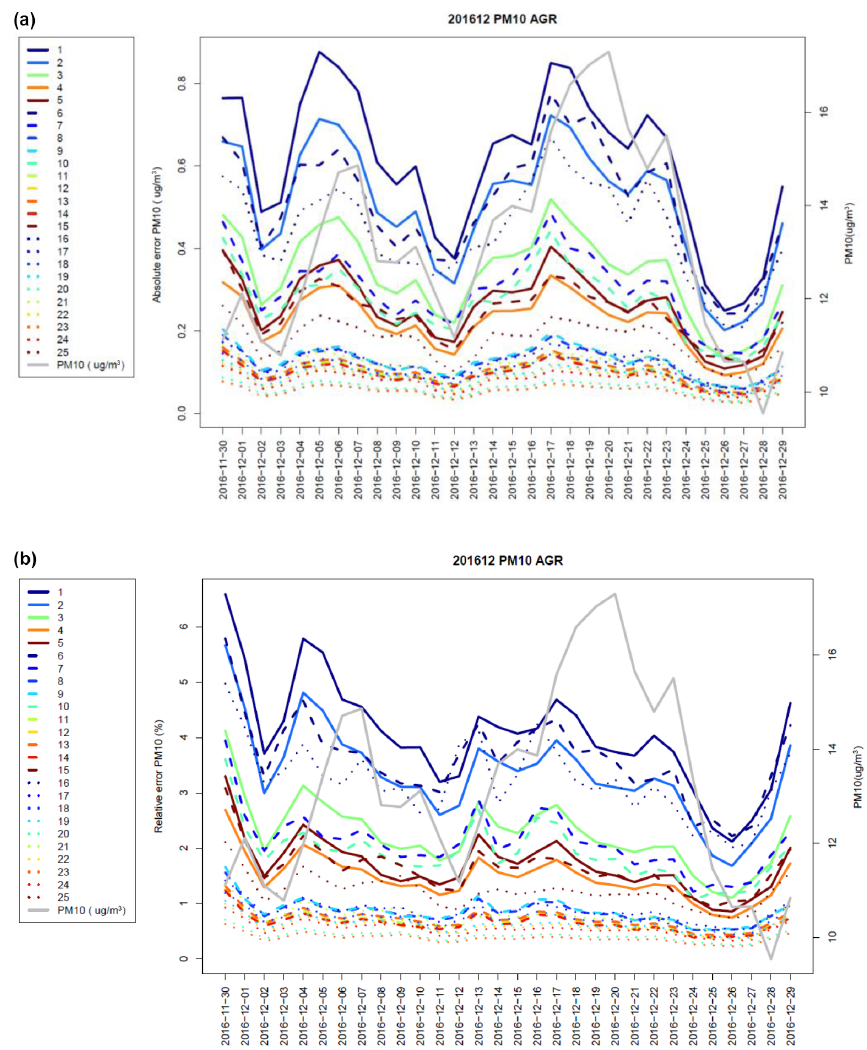
Figure 3. Absolute ( a , µgm − 3 ) and relative ( b , %) error over western Europe of the univariate surrogate model for the agriculture activity sector in December 2016. The coloured lines are for individual polynomial surrogate models and training scenarios ( x axis: 5 linear, 10 quadratic and 10 cubic forms with indices of the x axis matching the rows of Table 1). The grey curve gives the day-to-day variation of PM 10 (µgm − 3 ) averaged over the region (displayed on the right-hand-side y